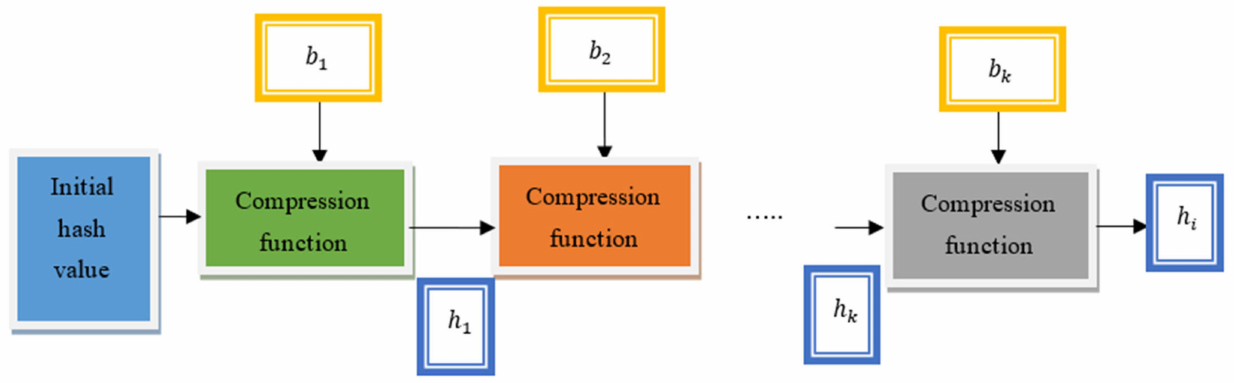
Figure 6. Block diagram of hash generation to generate the hash with the use of the Miyaguchi–Preneel compression